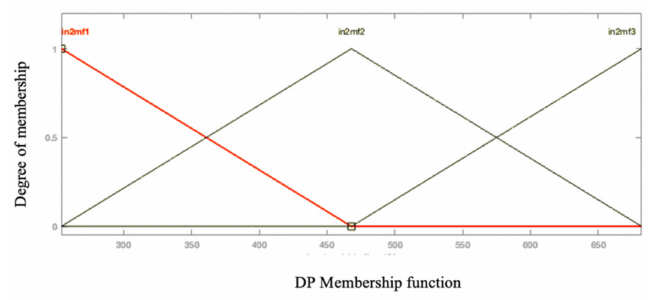
Figure 7. Proposed ANFIS DP Membership